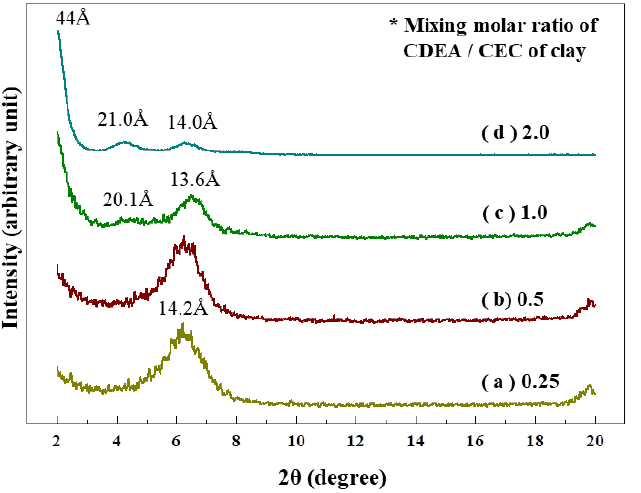
Figure 2. XRD patterns of CDEA – montmorillonite composites as a function of the mixing molar ratio of CDEA:CEC of clay. of CDEA:CEC of